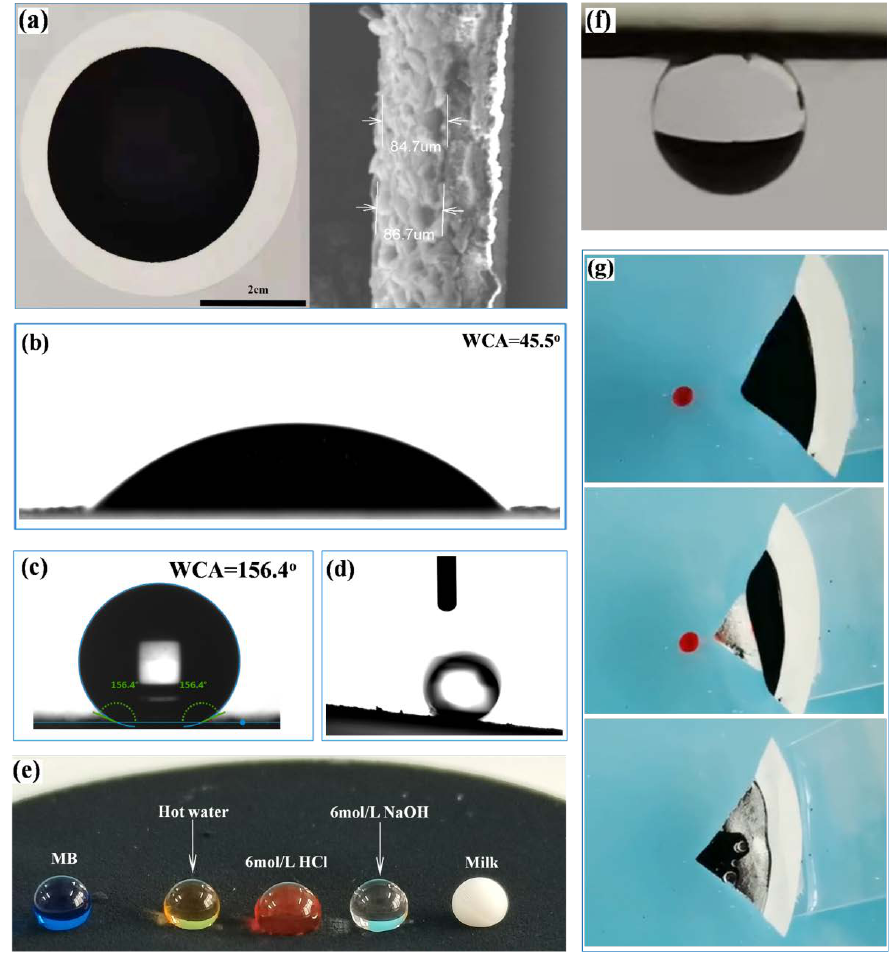
Figure 4. ( a ) Photograph of HSMX membrane and SEM image of its cross-section. Water contact angles of ( b ) MXene and ( c ) HSMX membranes, ( d ) rolling angle of water droplet on HSMX mem- brane, ( e ) different droplets on HSMX membrane, ( f ) water droplet hanging upside down on HSMX membrane. ( g ) Photographs of separating dichloromethane from the water-in-oil system using HSMX membrane and the silver mirror phenomenon.